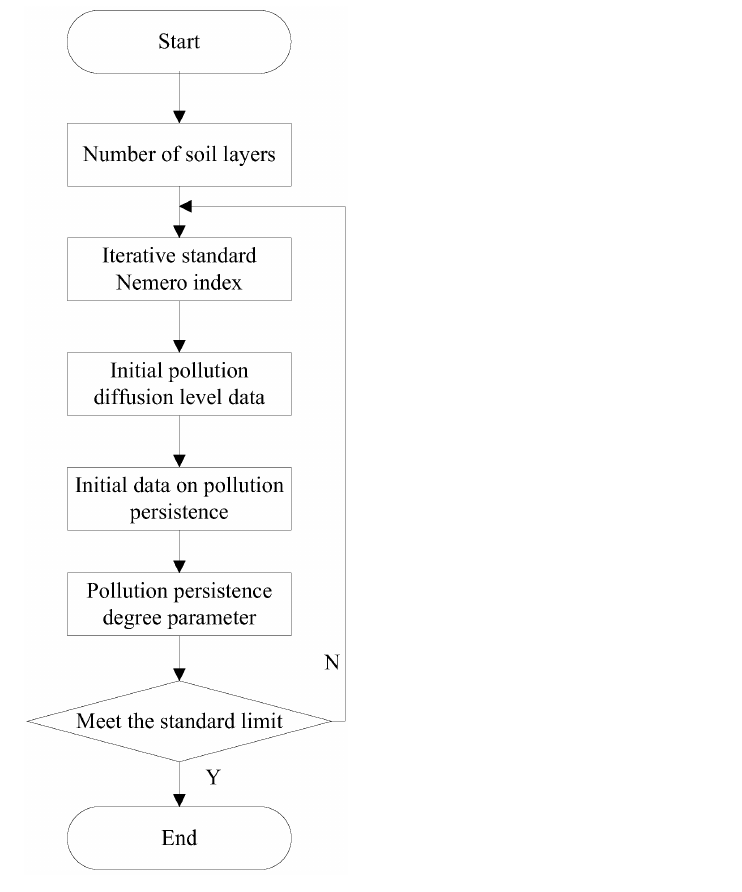
Figure 2. Flow chart of constructing the evaluation model of SHMP